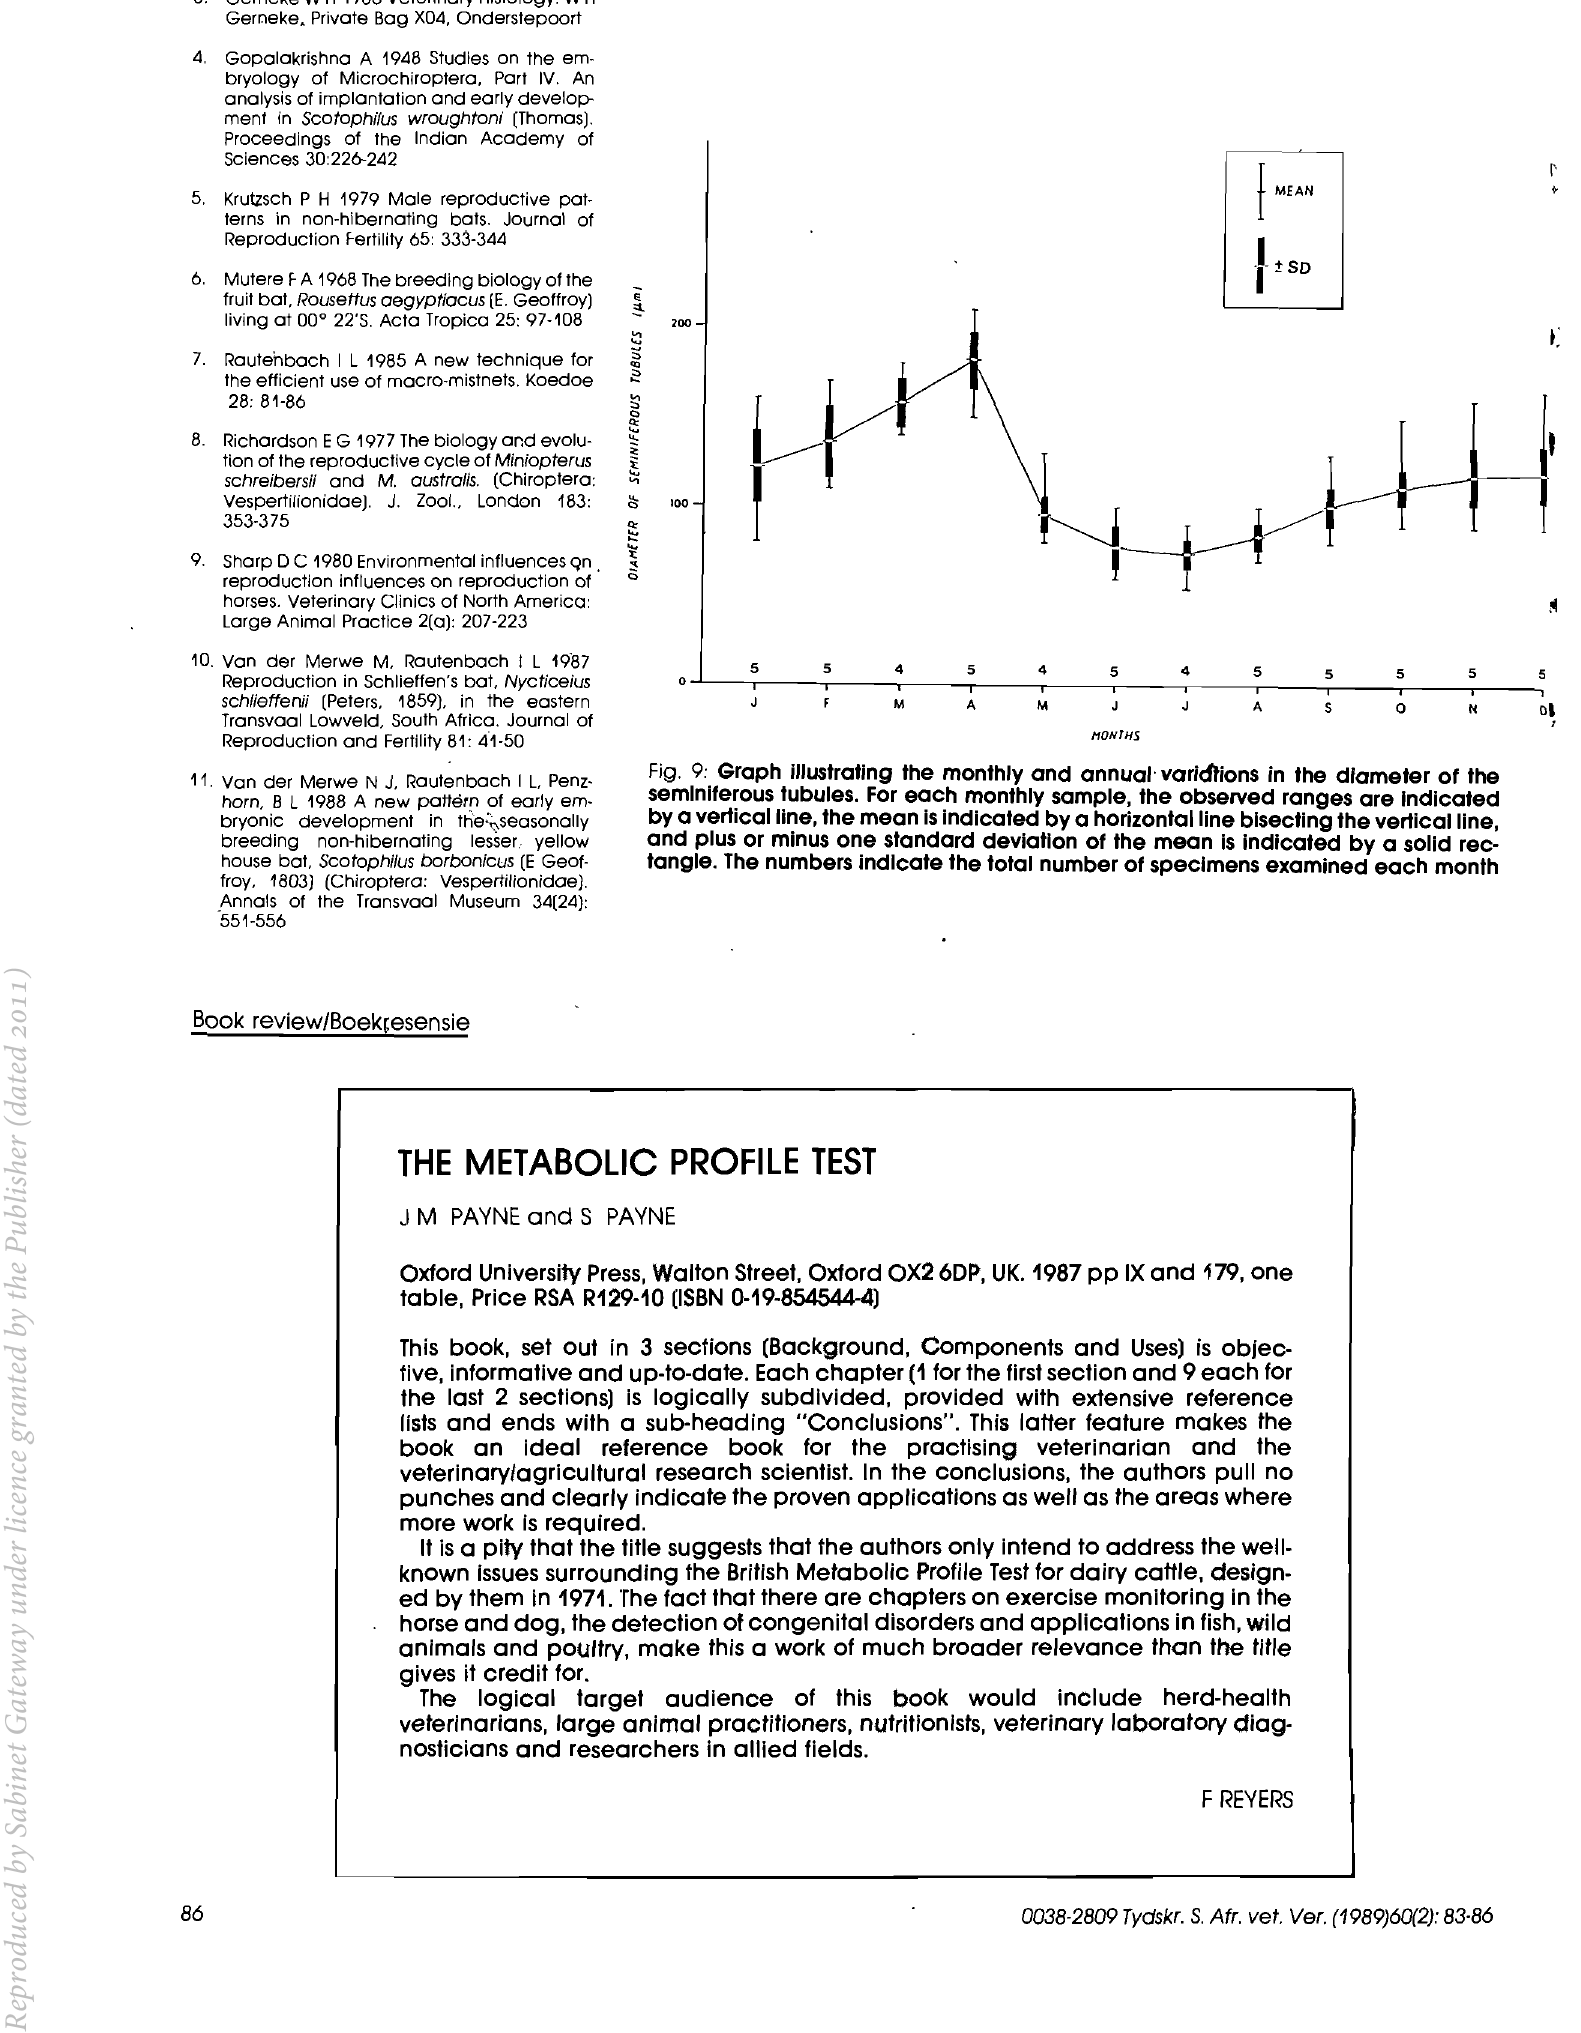
table, Price RSA R129-10 (ISBN